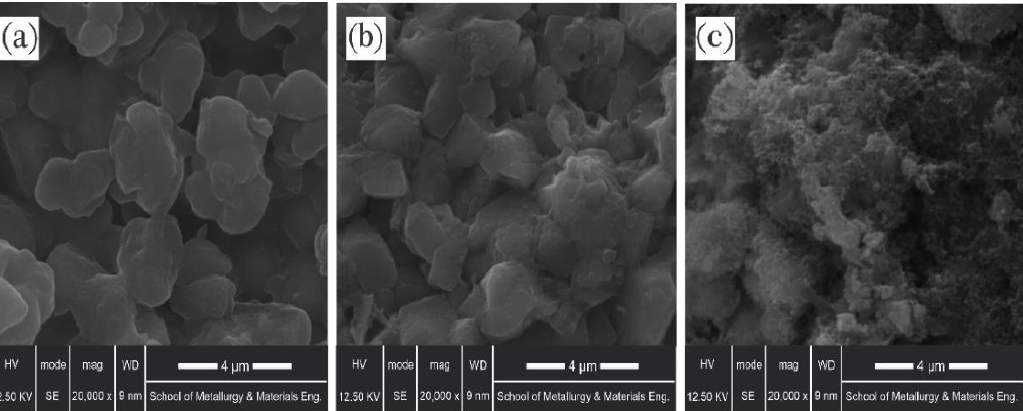
Figure 11. SEM images of the rock samples, ( a ) soaked in crude oil, ( b ) treated with Si-NH 2 , and ( c ) drenched in Si-NH 2 -surfactant.